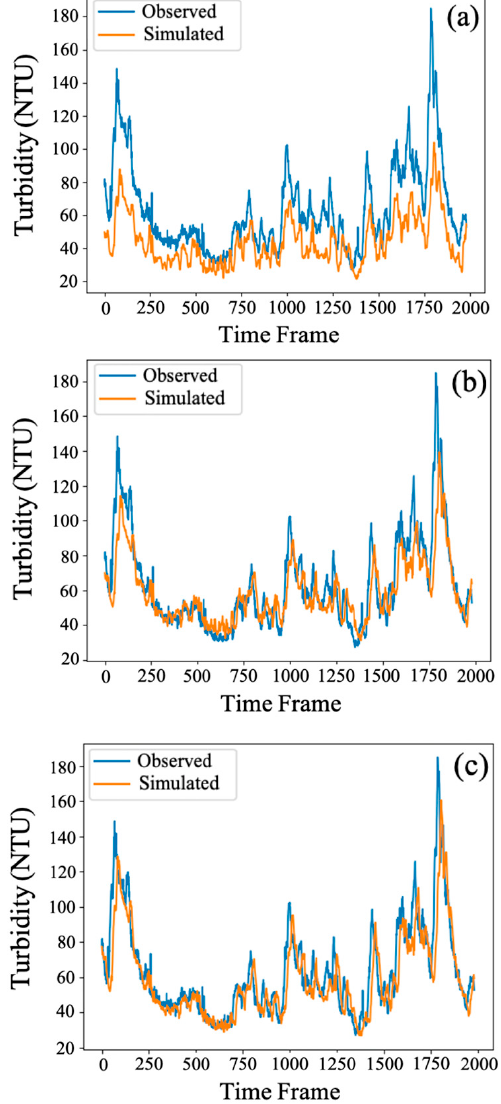
Figure 6. Observed and simulated turbidity based on data collected at S2. Simulated turbidity using different sizes of training set: ( a ) 600, ( b ) 3000, and ( c ) 9000 sets.